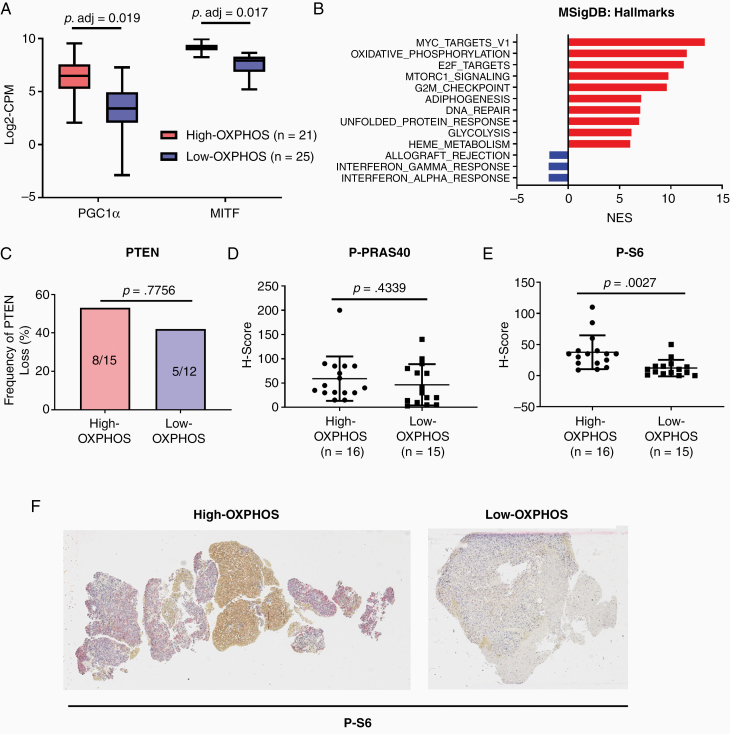
Molecular associations of OXPHOS in melanoma brain metastases. (A) Gene expression analysis of PGC1α and MITF (by RNAseq) in High-(Red) versus Low-OXPHOS (Blue) melanoma brain metastases (MBMs). Each plot is a simple box and whisker plot. Median values (lines) and interquartile range (whiskers) are indicated. Adjusted P values calculated via generalized linear model analysis are listed. (B) Cumulative GSEA-P enrichment plot demonstrating significant enrichment or depletion (false discovery rate [FDR] q-val < 0.0001) of MSigDB Hallmarks gene sets in High-OXPHOS versus Low-OXPHOS MBMS identified via clustering methods. The 10 most up-regulated gene sets are shown in red. All significantly down-regulated gene sets are shown in blue. The normalized enrichment score forms the x-axis. (C) Comparison of the prevalence of complete PTEN loss by IHC for High-OXPHOS and Low-OXPHOS MBMs. Y-axis represents the frequency (%) of MBMs with complete absence of PTEN expression. Significance determined via 2-sided Fisher’s exact test. (D) Comparison of P-PRAS40 IHC expression by H-scores for High-OXPHOS versus Low-OXPHOS MBMs. Lines represent mean ± SD; each dot represents a single tumor. Significance determined via 2-sided Student’s t-test. (E) Comparison of P-S6 IHC expression by H-scores for High-OXPHOS versus Low-OXPHOS MBMs. (F) Representative P-S6 staining in High- and Low-OXPHOS MBMs. Samples selected reflect the median H-scores in the High- (median = 35) and Low- (median = 10) OXPHOS MBMs. Tumor cells are present throughout the entirety of both samples.